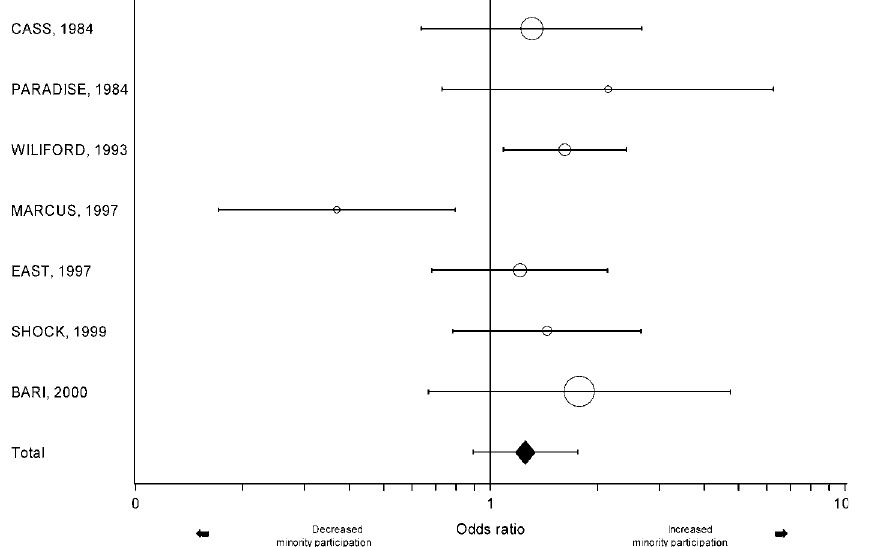
Figure 4. Comparison of Minority versus non-Hispanic White Consent Rates in Surgical Intervention Trials Circle diameter is proportional to the sample size of the individual studies. The diamond represents the overall OR. The vertical line indicates the 95% confidence interval on the OR. DOI: